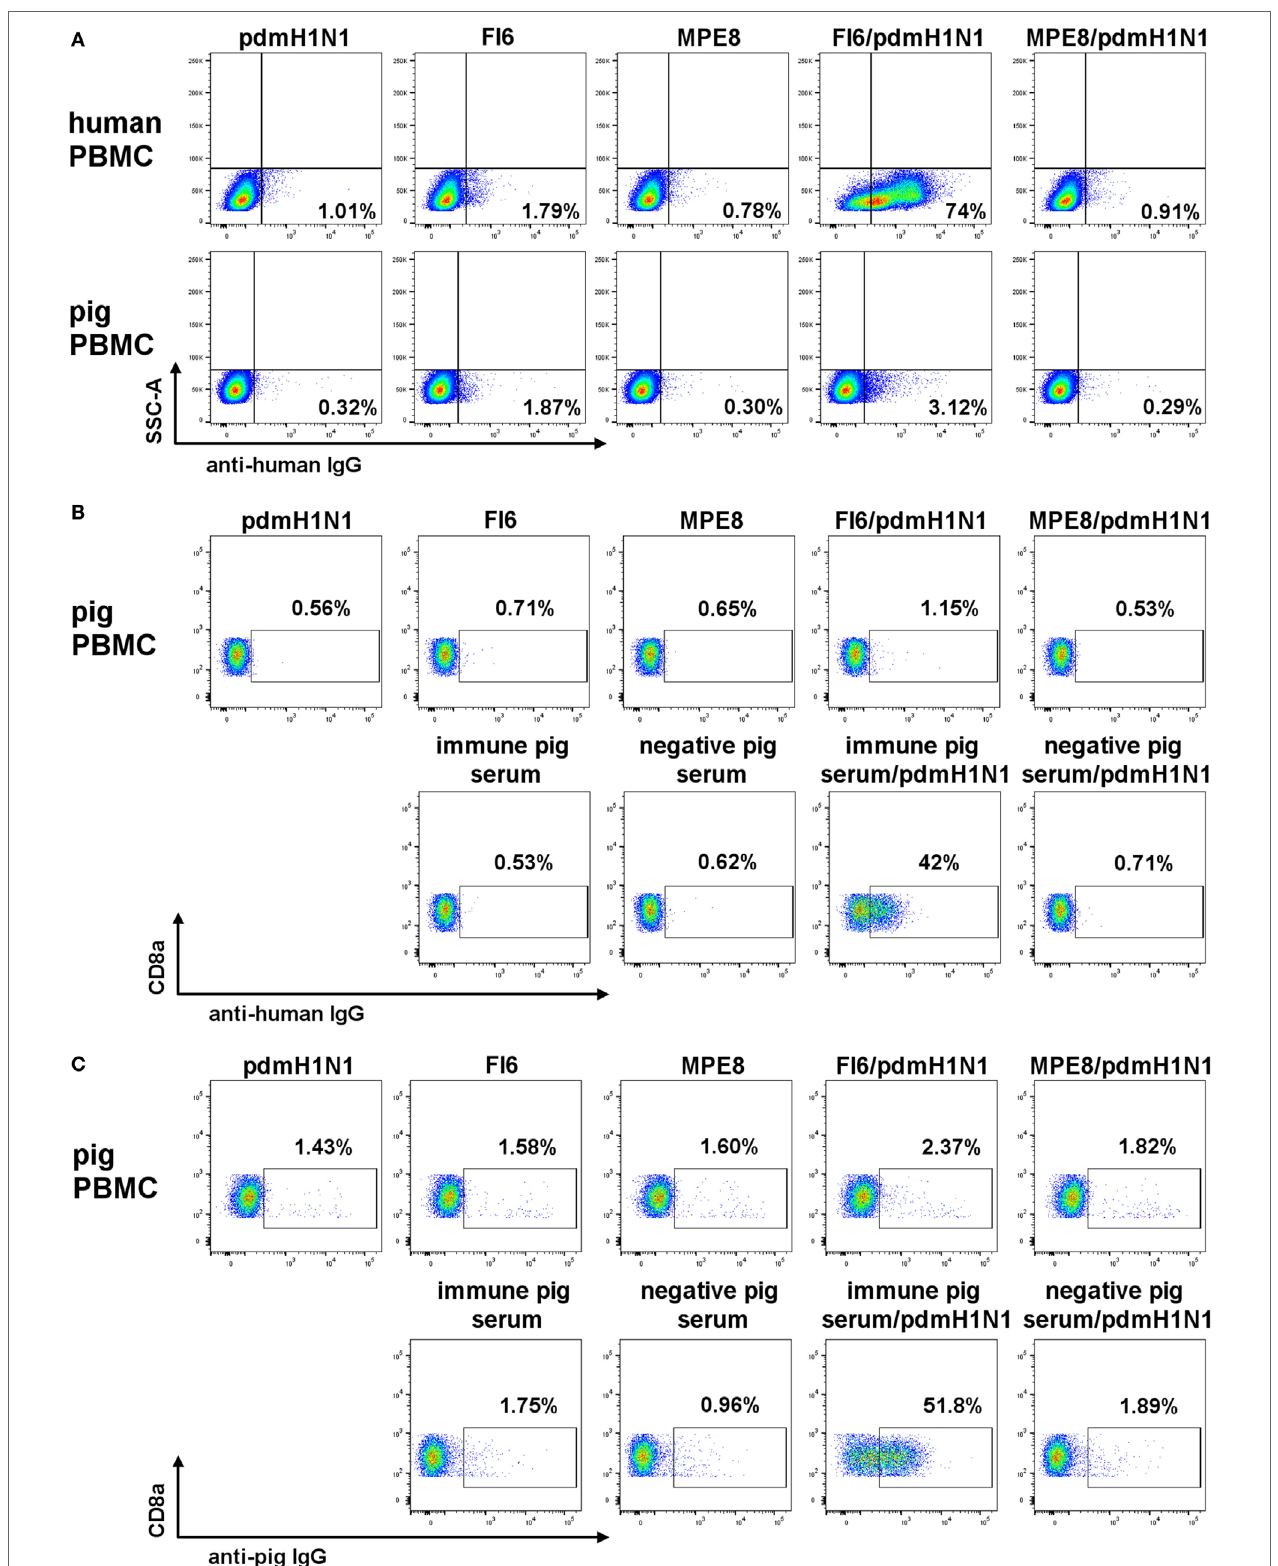
FigUre 5 | FI6 binding to human and pig Fc receptors. Antibody and pdmH1N1 virus were pre-incubated for 1 h at 37°C and then added to either human or pig PBMC. (a) Gated on live cells, singlets, and SSCA versus IgG FITC. (B,c) Gated on live cells, singlets, and CD3 − CD8 α + IgG